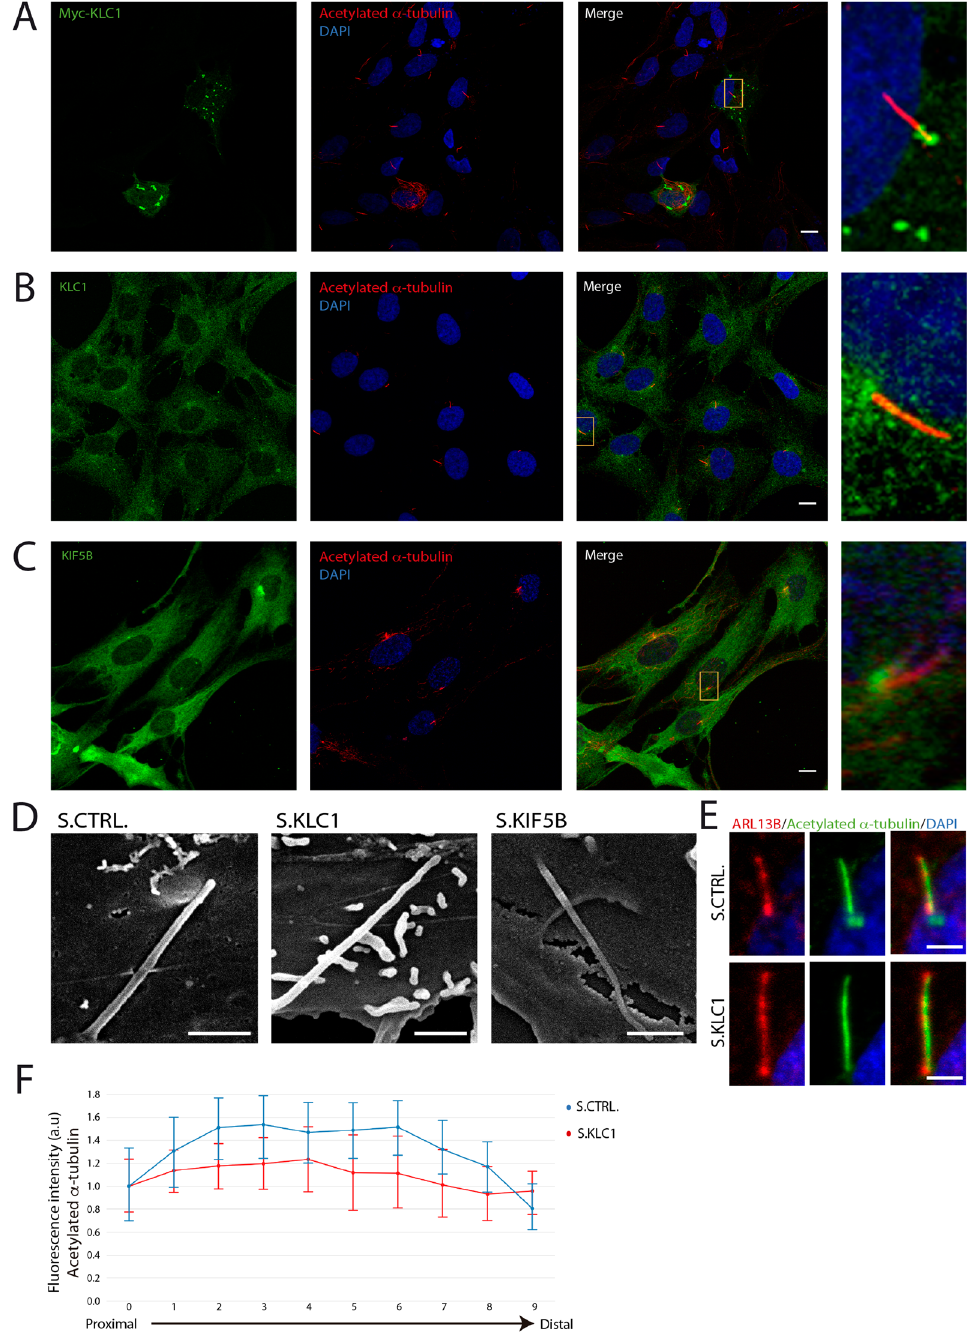
Figure 3. KLC1 and KIF5B are found at the base of cilia. Confocal microscopy analysis of hTERT-RPE cells. ( A ) Cells were transfected to overexpress Myc-tagged KLC1. In addition to cytoplasmic aggregates, a pool of Myc-KLC1 (anti-Myc, green) is found at the base of cilia (anti acetylated α -tubulin, red). ( B ) In addition to a diffuse cytoplasmic signal, the anti-KLC1 antibody shows an accumulation of endogenous protein at the base of cilia. ( C ) Similarly, endogenous KIF5B is found in the cytoplasm and also concentrated at the base of cilia. Yellow boxes mark the area that is magnified and showed in panels on the right. DAPI was used to stain nuclei. Scale bars correspond to 10 μ m. ( D ) Scanning electron micrographs showing cilia in hTERT-RPE cells transfected with control (S.CTRL), KLC1 (S.KLC1) or KIF5B (S.KIF5B) stealth RNA oligos. Scale bars correspond to 1 μ m. ( E , F ) The level of tubulin acetylation in control and KLC1 KD cilia was quantified measuring the fluorescence intensity of the signal obtained using the acetylated α -tubulin antibody (green). The anti-ARL13 (red) signal was used to mark the entire length of the cilium. Scale bars correspond to 2 μ m. Each cilium was divided in 10 segments from base to tip (see methods) and the mean intensity was computed. For each experiment (KLC1 KD and control) a ten-point intensity profile was computed by averaging the measure of all cilia in each one of the regions of interest. These profiles are shown, normalized by the measure of its first region of interest. Vertical bars plot the 95% confidence interval about the